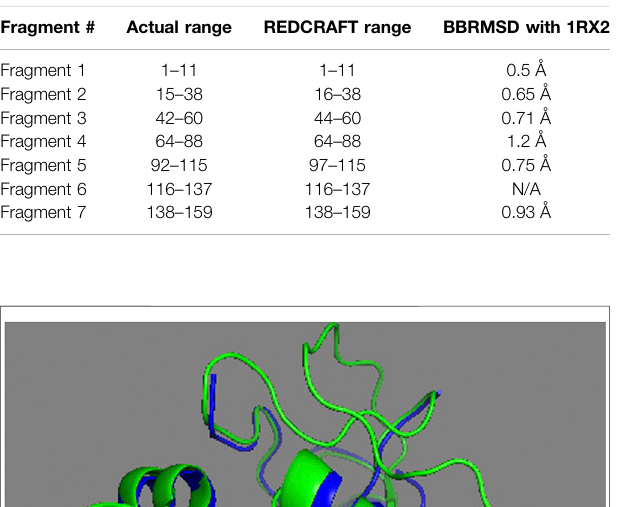
TABLE 4 | Results of progressive fragment assembly as investigation all inversion degeneracies. The reported scores are Q-Factors determined by